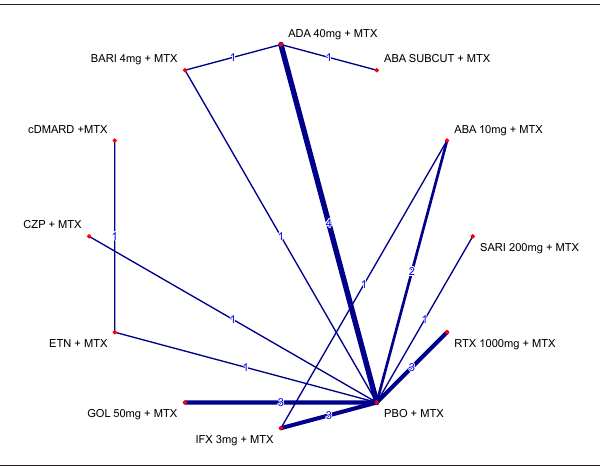
Figure 1. Network of Evidence for ACR20 Response at Week 24 (MTX-IR Population; Primary